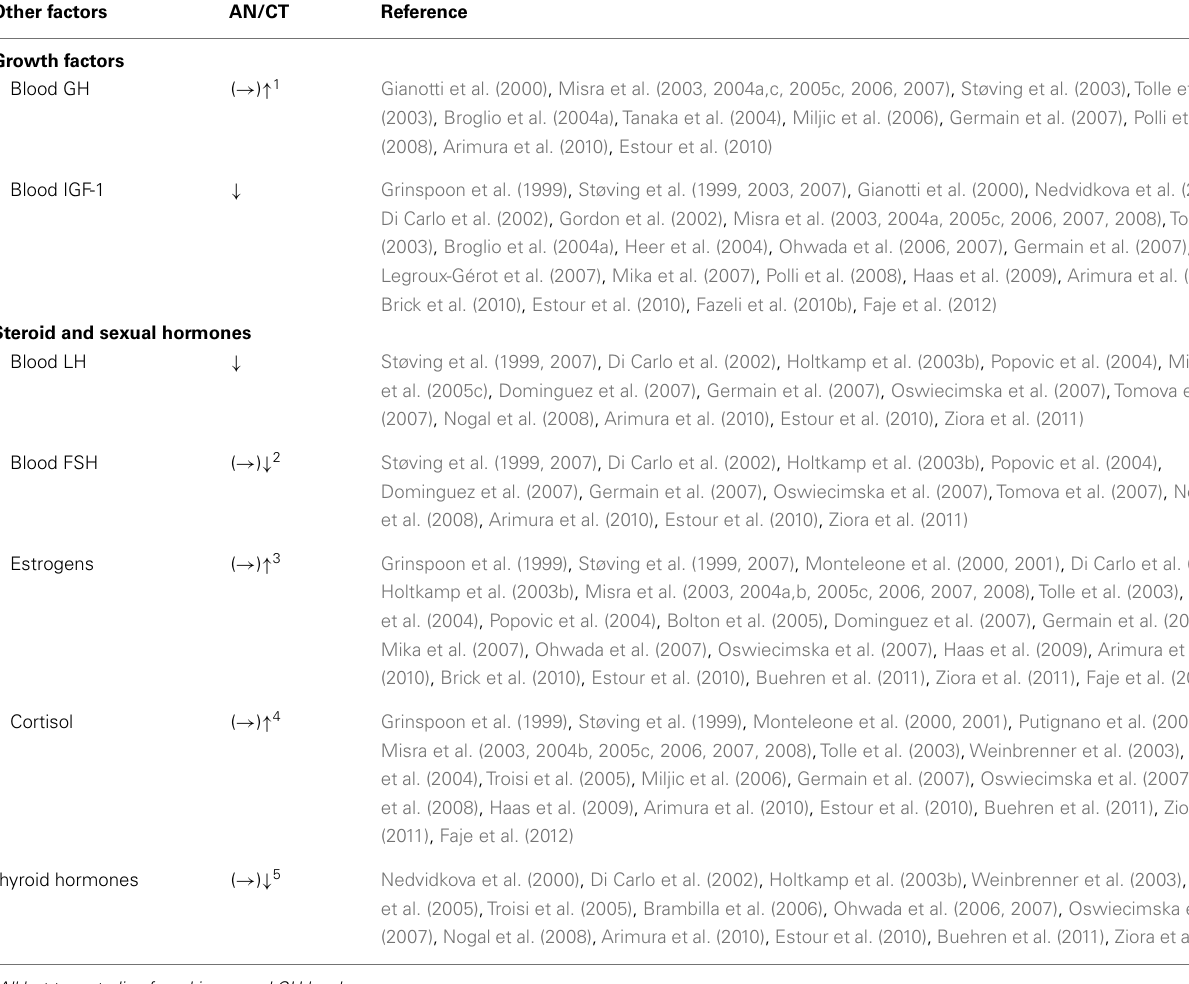
Table 6 | Compared levels of other factors altered inAN